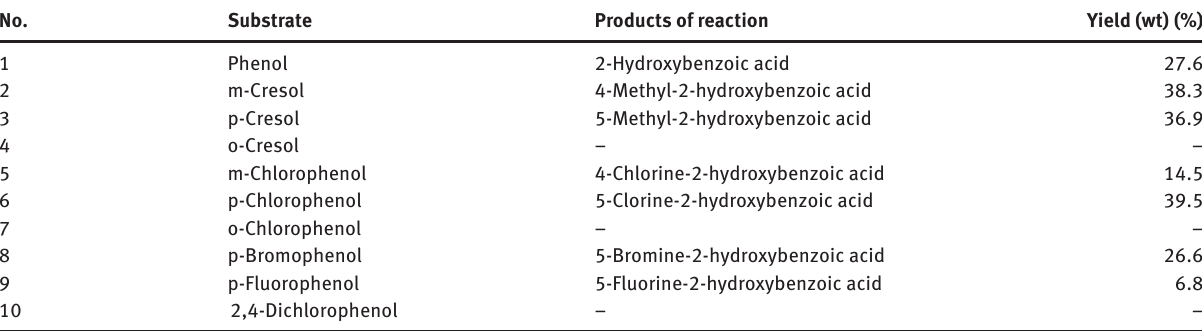
Table 3: Comparative activity of phenol and its derivatives in carboxylation reaction with sodium ethyl carbonate under MW-irradiation (power 450 W, time 9 min, [substratum] : [sodium ethyl carbonate] = 1.5 : 1).